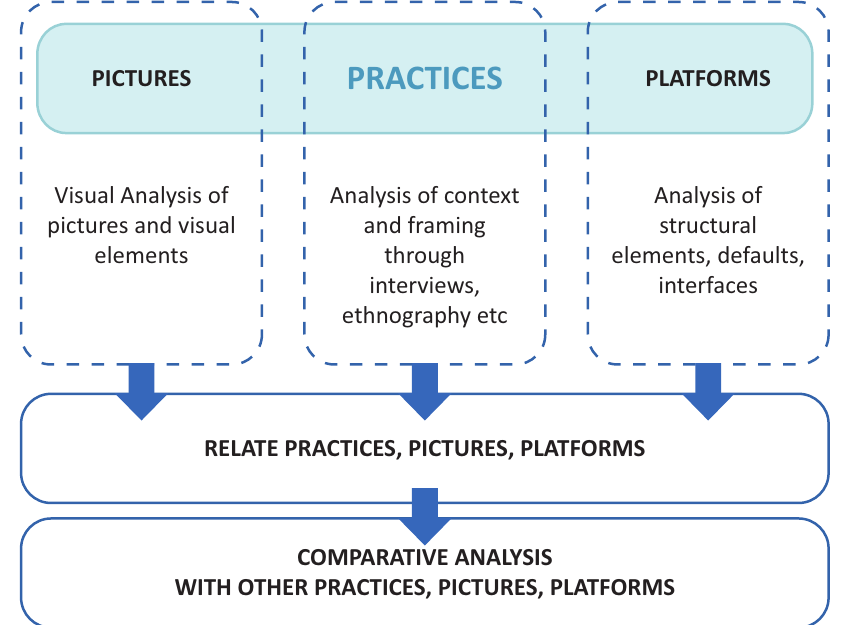
Figure 1. Framework for analysing visual communication on social